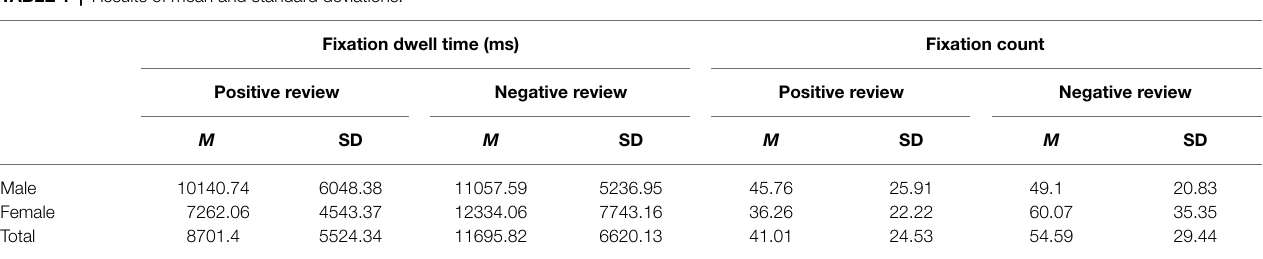
TABLE 1 | Results of mean and standard